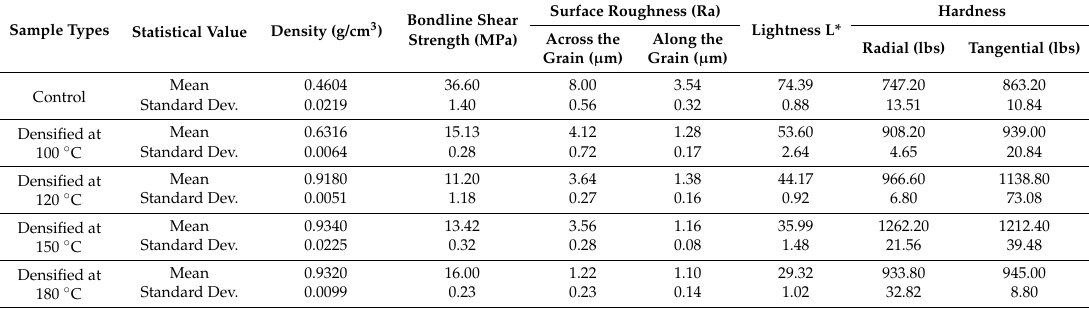
Table 2. Average physical and mechanical properties of densified eastern redcedar at a pressure of 6.08 MPa and different temperature levels.